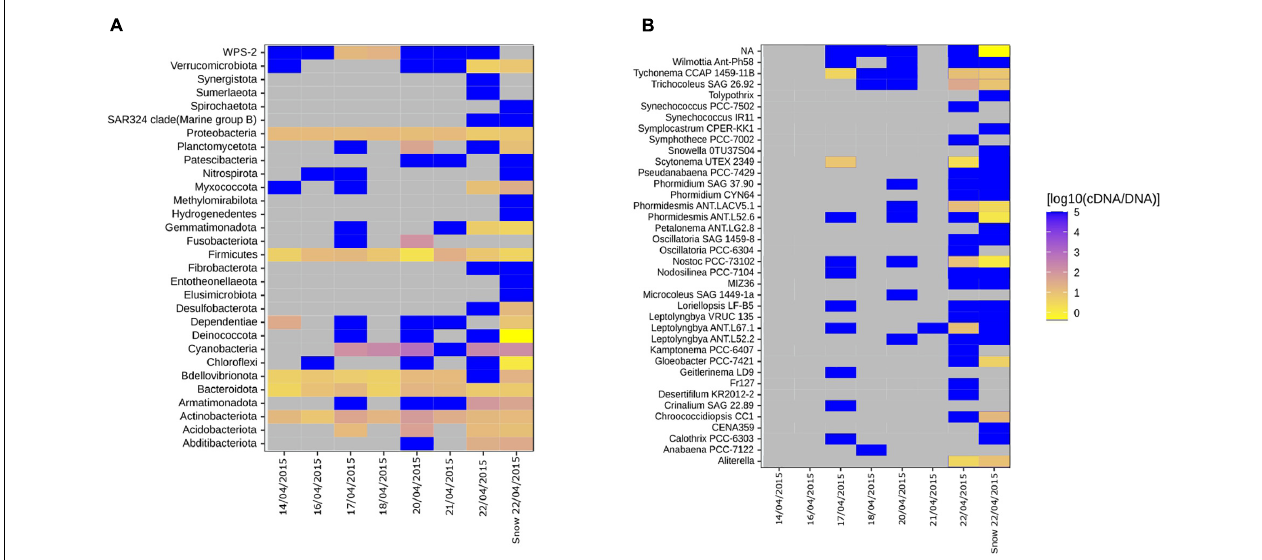
FIGURE 4 | Heatmaps showing the ratio between the proportion of a clade in the cDNA-level and in DNA-level community for individual air samples and mean snow samples. (A) All phyla. (B) Genera associated with the Cyanobacterial phyla. Gray tiles indicate that the specific taxon is not present in neither cDNA nor DNA-level community. Bright yellow indicate that the taxa is present in the DNA-level community but not in the cDNA-level community. Dark blue tiles indicate that the taxon is present in the cDNA-level community but not in the DNA-level community, which have previously been referred to as “phantom taxa” (Klein et al., 2016).